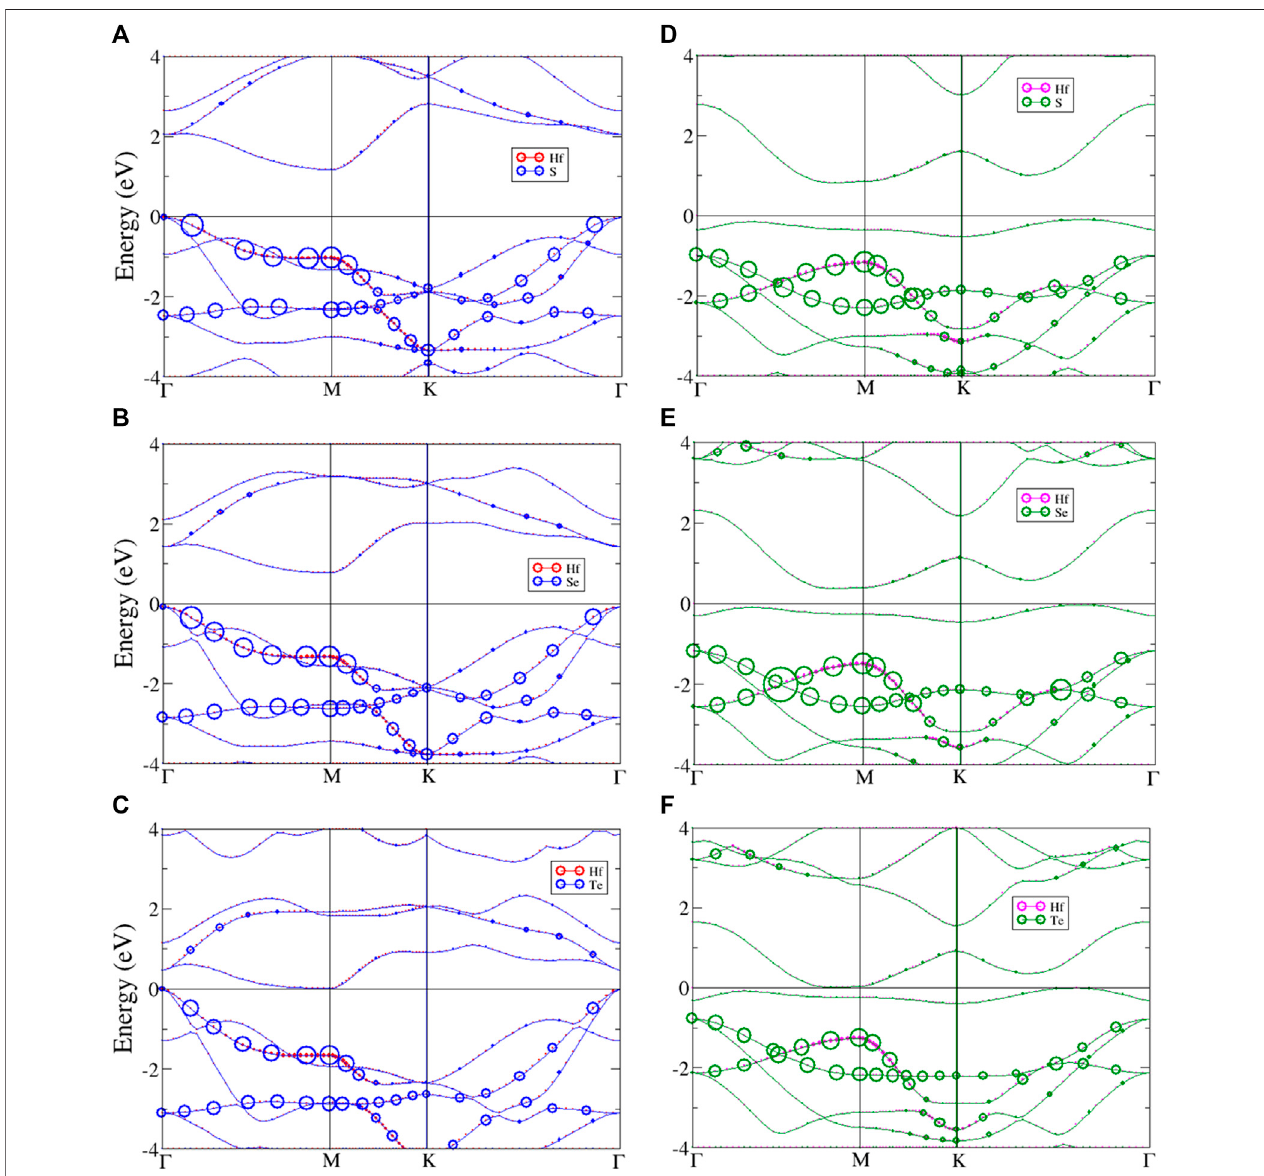
FIGURE 4 | The band energy spectrum of monolayer (A) HfS 2 , (B) HfSe 2 , (C) HfTe 2 with T phase, and (D) HfS 2 , (E) HfSe 2 , (F) HfTe 2 with H phase. The red, magenta, blue, and green circles describe the atom dominant in the band for Hf and chalcogen atoms in T and H phase, respectively.